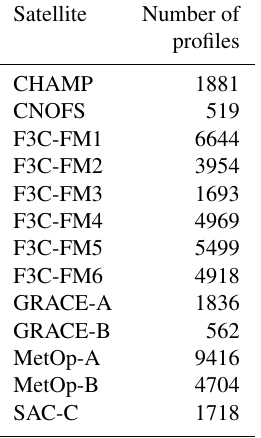
Table 5. Number of collocated RO profiles with TC for different RO